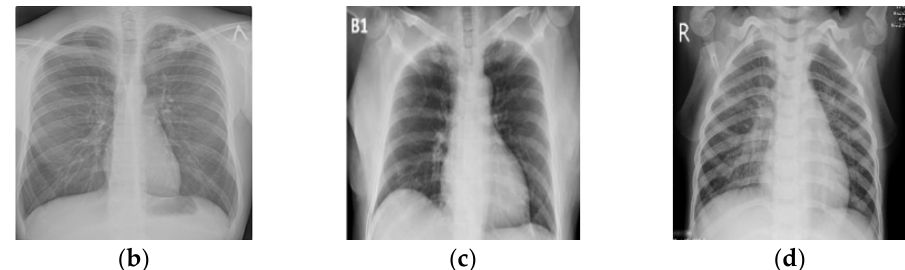
Figure 2. The Samples of X ‐ rays from 4 classes: ( a ) Normal sample; ( b ) Tuberculosis sample; ( c ) Coronavirus sample; ( d ) Viral ‐ Pneumonia sample. ( c ) Coronavirus sample; ( d ) Viral-Pneumonia sample.